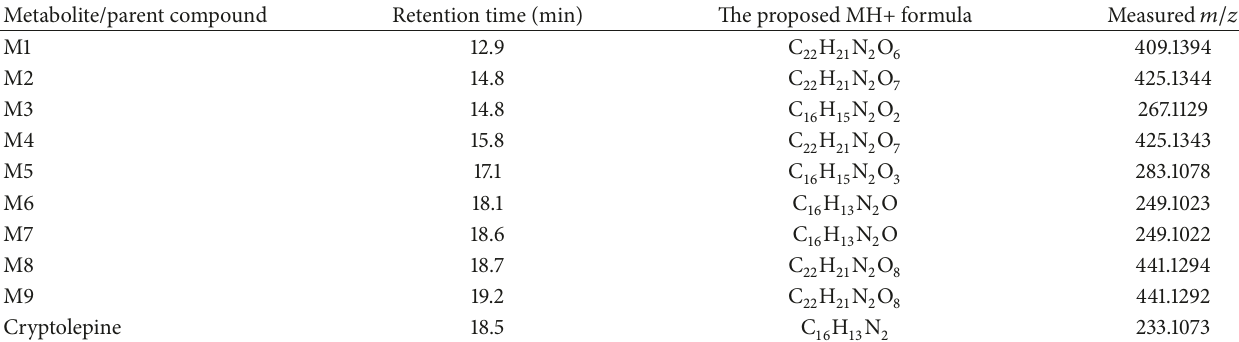
Table 5: Liquid chromatography-mass spectrometry data for cryptolepine and the proposed metabolites (adapted from Donkor